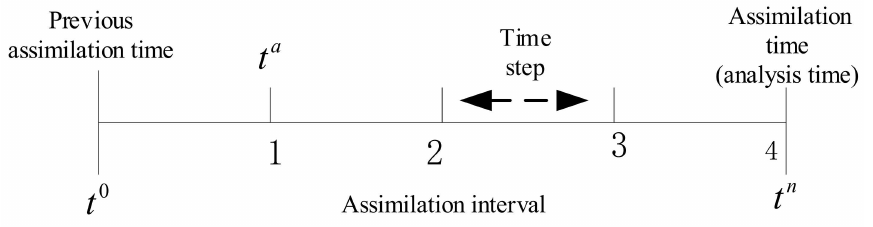
Figure 2. Schematic diagram showing the assimilation interval and the starting moment t a of statistical